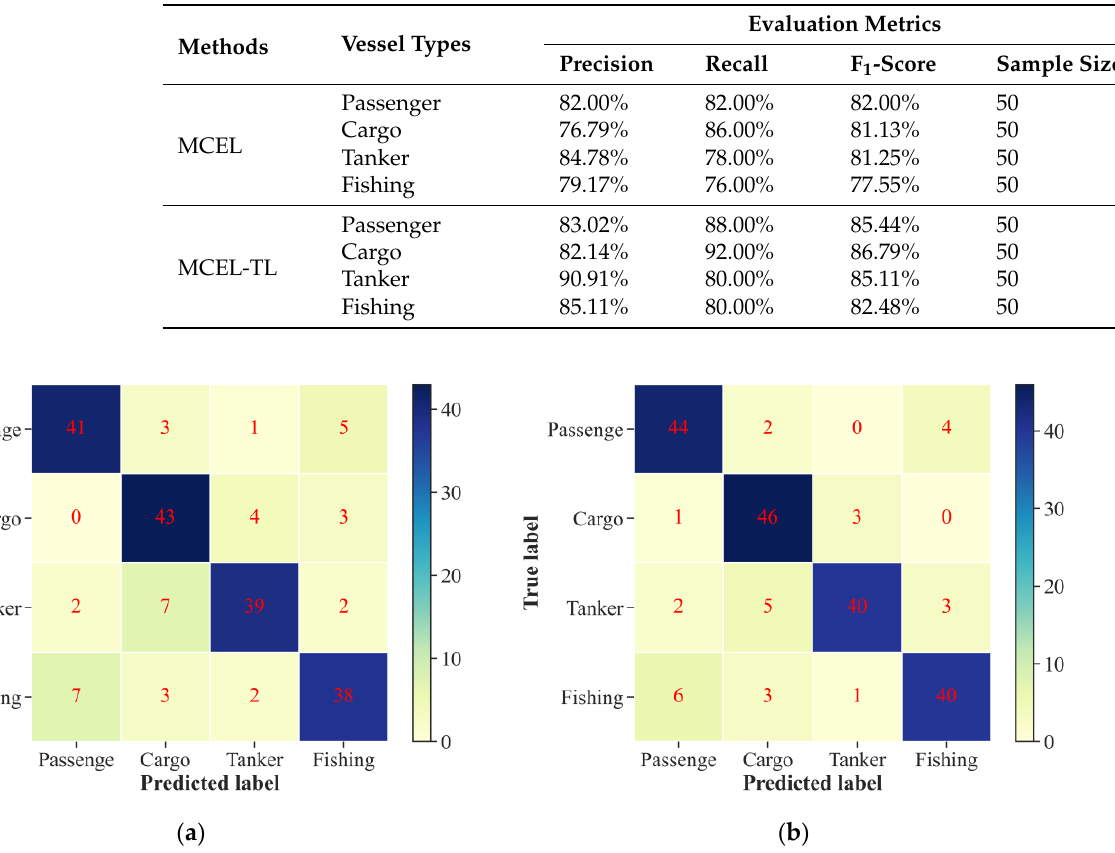
Figure 13. Confusion matrix of the MCEL model on the SAR test set with different training sets. ( a ) Confusion matrix of the MCEL model and ( b ) confusion matrix of the MCEL-TL model.